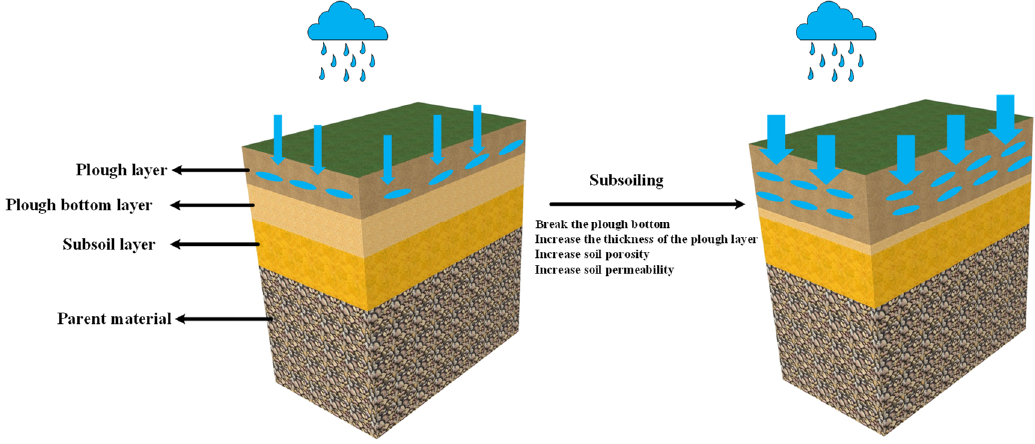
Figure 6. Schematic diagram of the effect of subsoiling on the soil plough layer.